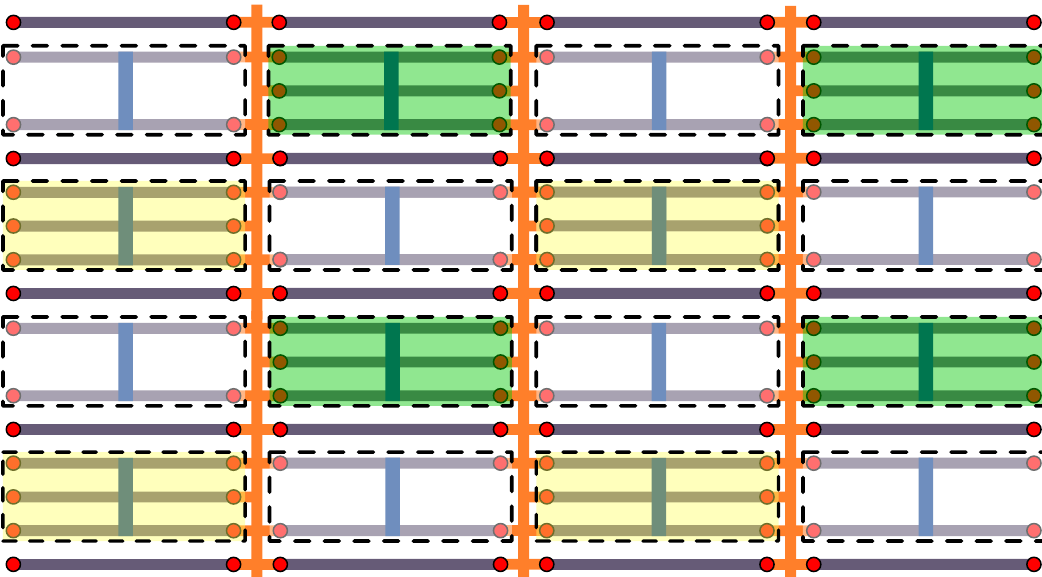
Figure 6: A proposed architecture layout for implementing a surface code. The tetrons (shown enclosed in unshaded dashed rectangles) play the role of data qubits in the surface code, while hexons (shown enclosed in shaded dashed rect- angles) play the role of ancillary qubits used to facilitate the stabilizer measure- ment. The yellow and green shading of rectangles correspond to the M hexons, respectively, which facilitate measuring the X ⊗ 4 and Z ⊗ 4 stabilizers on their nearest-neighboring data qubits. Coherent links (shown between vertical neighboring islands) are a necessary aid to enable the full set of Pauli measure-